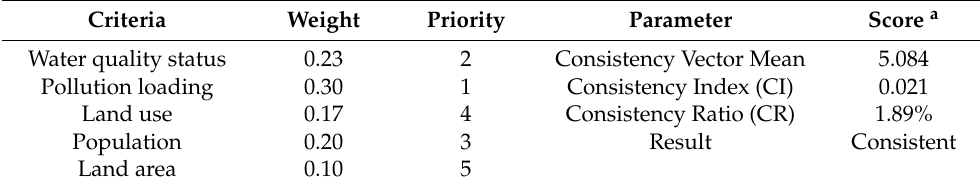
Table 2. The weighting of segment